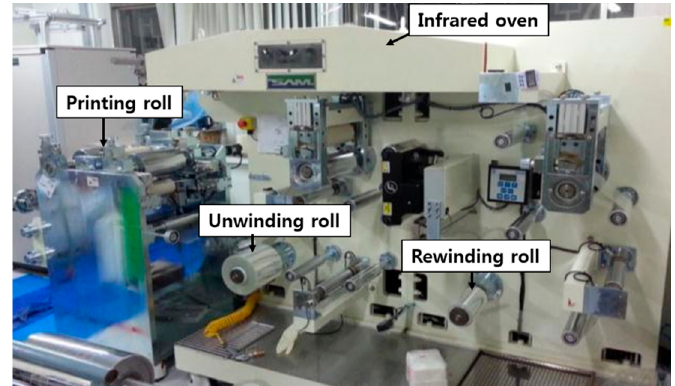
Figure 5. Roll-to-roll gravure printer.